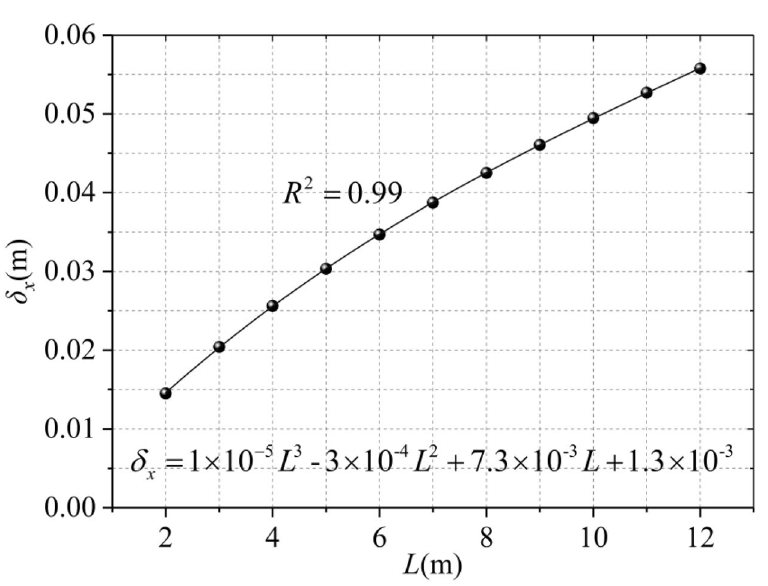
Figure 9. Maximum horizontal displacement of different trench